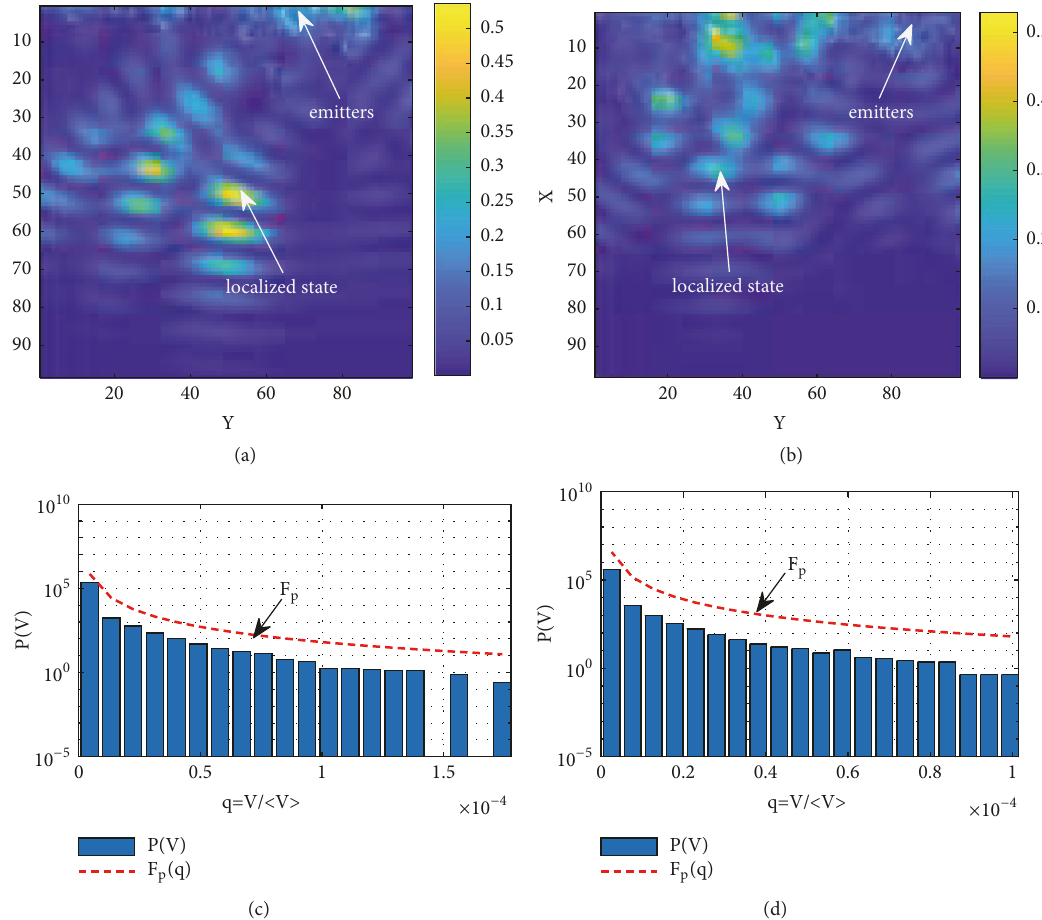
Figure 4: The same as in Figure 3 but for long time 𝑡 = 10 that corresponds to a developed state when the emitters already acquire well- synchronized phases. From(a), (b) we observethat thefield amplitudes already havelarge values (see colorbar images in (a), (b)).Besides, one can see that in this case the speckles migrate to rather long distance from the initial positions, where they were generated (see Figure 4(a)); (c), (d) the intensity 𝑉 and the stationary probability function (dashed red line) (6) that, however, already does not fit well the histograms